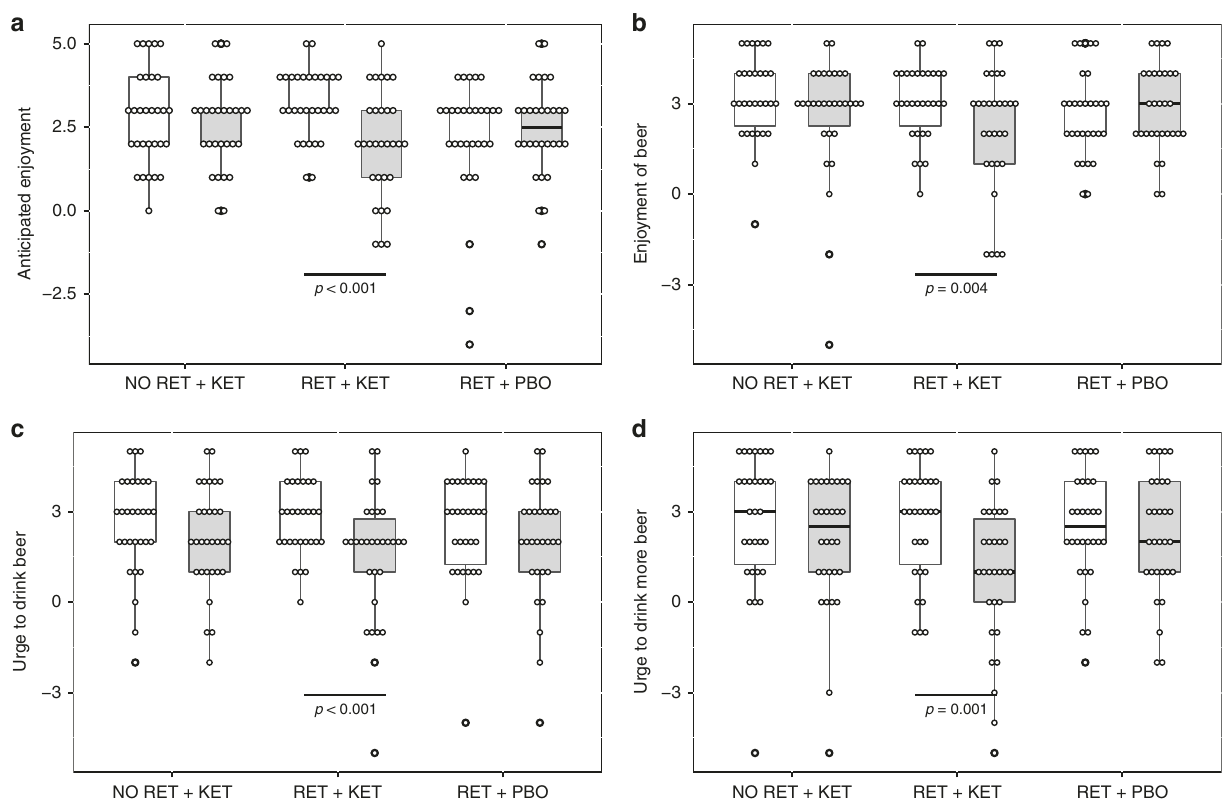
Fig. 1 Reductions in motivational and reinforcing properties of beer in RET + KET from Day 1 (baseline) to Day 10 (post manipulation). a Anticipated enjoyment of beer. b Post consumption actual enjoyment, c Urge to drink beer, d Post consumption urge to drink more beer. In all cases, signi fi cant reductions were observed only in RET + KET. Boxes represent mean ± IQR, whiskers represent range. Dots are individual data points. P values represent F tests on multivariate simple-effects of Time within. Source data are provided as a Source Data fi